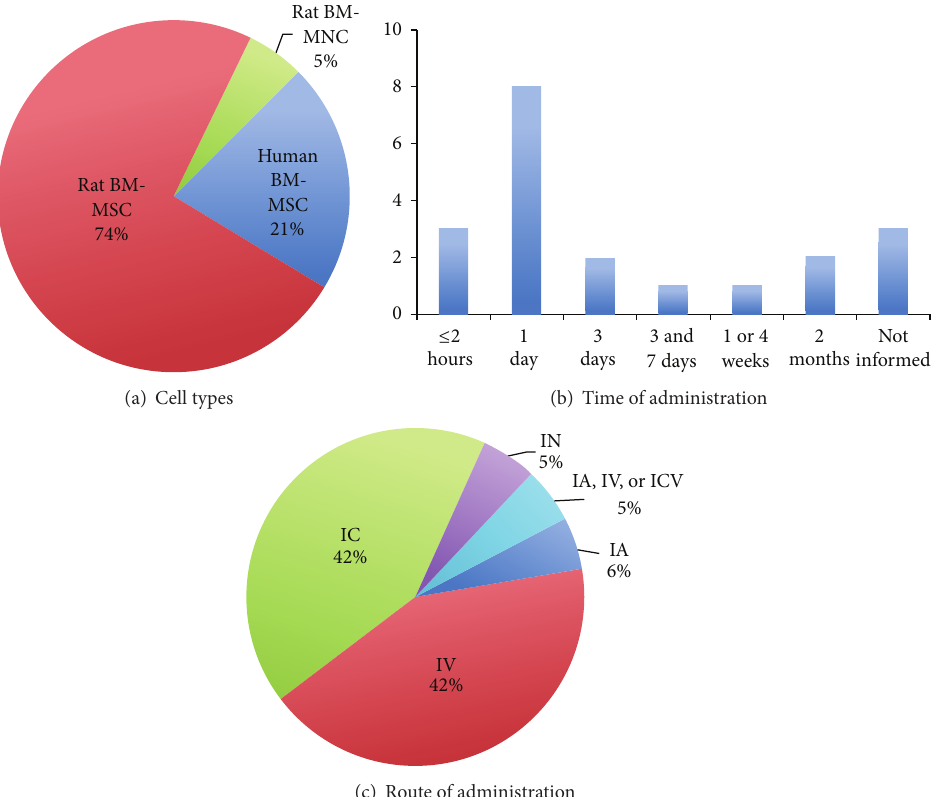
Figure 2: Charts summarizing the type of bone marrow-derived cells (a), time of injection (b), and route of administration (c) in preclinical studies for hemorrhagic